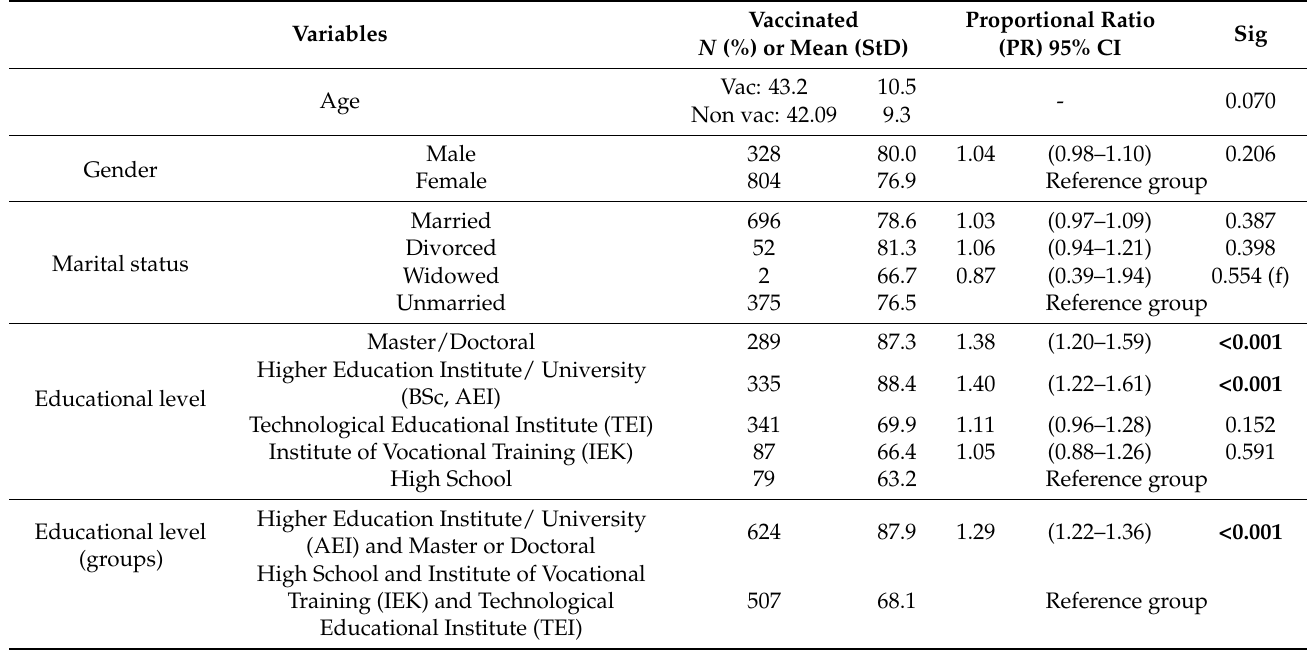
Table 1. Demographical characteristics (gender, age, marital status, educational level) associated with COVID-19 vaccine acceptance, expressed with proportional ratio in univariate analysis.